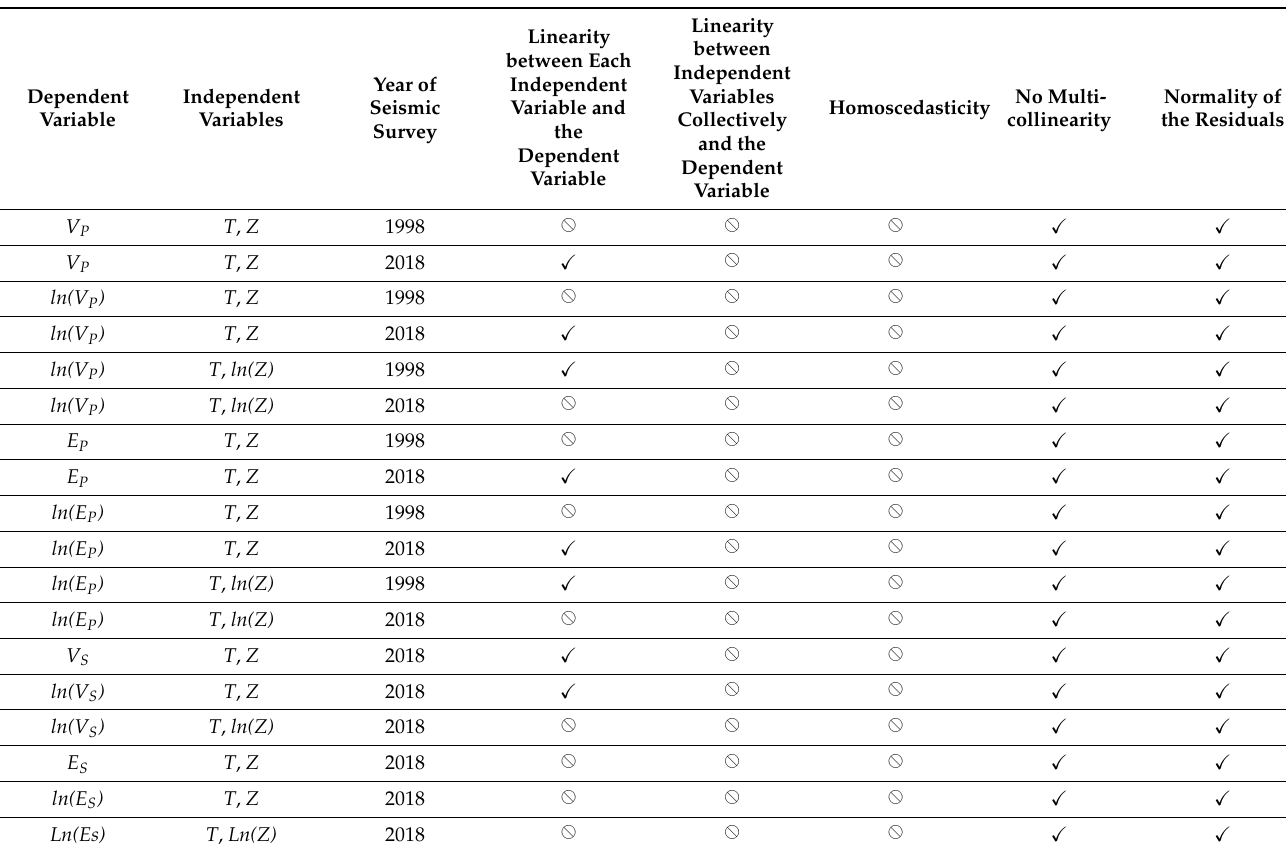
Table 1. Results of testing critical assumptions of multiple linear regression models with seismic velocity or elastic modulus as the dependent variable and both temperature ( T ) and elevation ( Z ) as independent